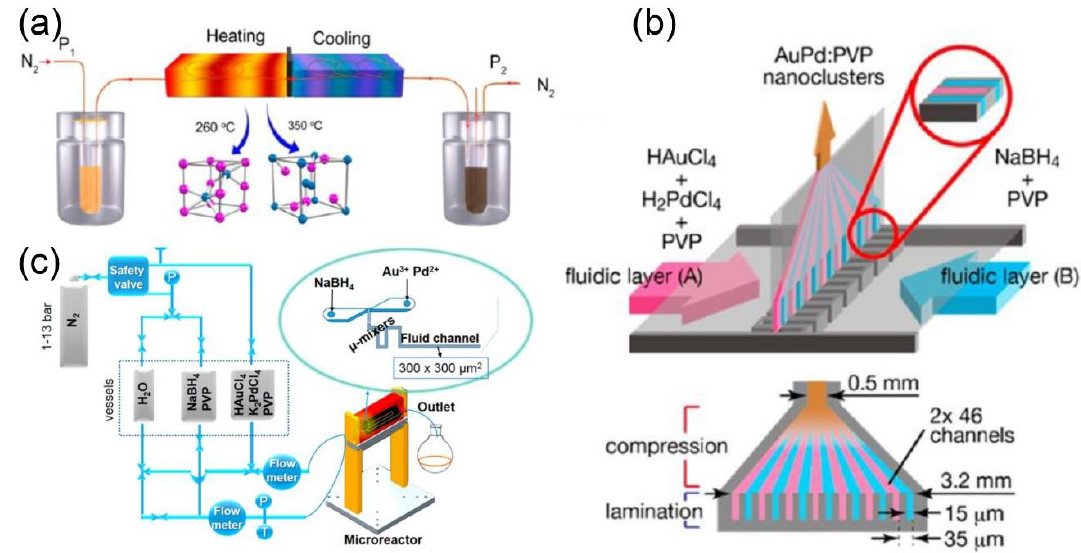
Figure 7. ( a ) Schematic representation of the microfluidic reactor system for the fabrication of Pt-Bi nanoparticles (reproduced from [53], with permission from the American Chemical Society, 2015). ( b ) Schematic illustration of the microfluidic mixing device for the synthesis of pure and bimetallic nanoparticles (reproduced from [54], with permission from the American Chemical Society, 2014). ( c ) Schematic illustration of the microfluidic setup for synthesis of polyvinyl pyrrolidone (PVP)-stabilized monometallic and bimetallic nanoparticles (reproduced from [55], with permission from the American Chemical Society, 2018).